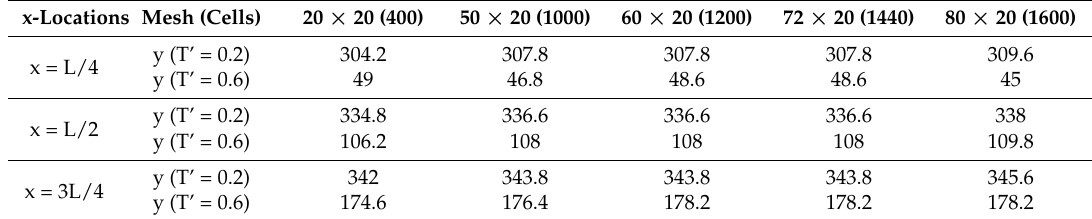
Figure 6. Sensitivity analysis for different grid sizes: ( a ) Ra = 200; ( b ) Ra = 300; and ( c ) Ra = 400 (—: (20 × 80); · · · · · · : (20 × 50); - - -: (20 × 80)). Table 2. Deviations in the sensitivity analysis for Ra = 300.